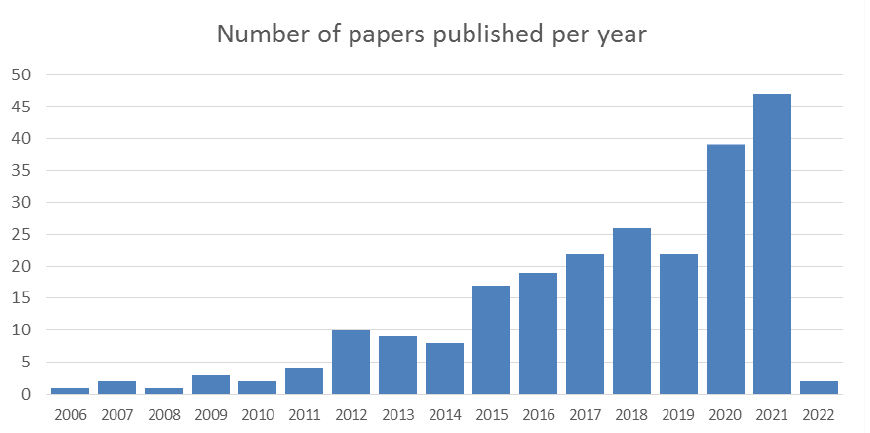
Figure 2. Number of articles per year of publication.